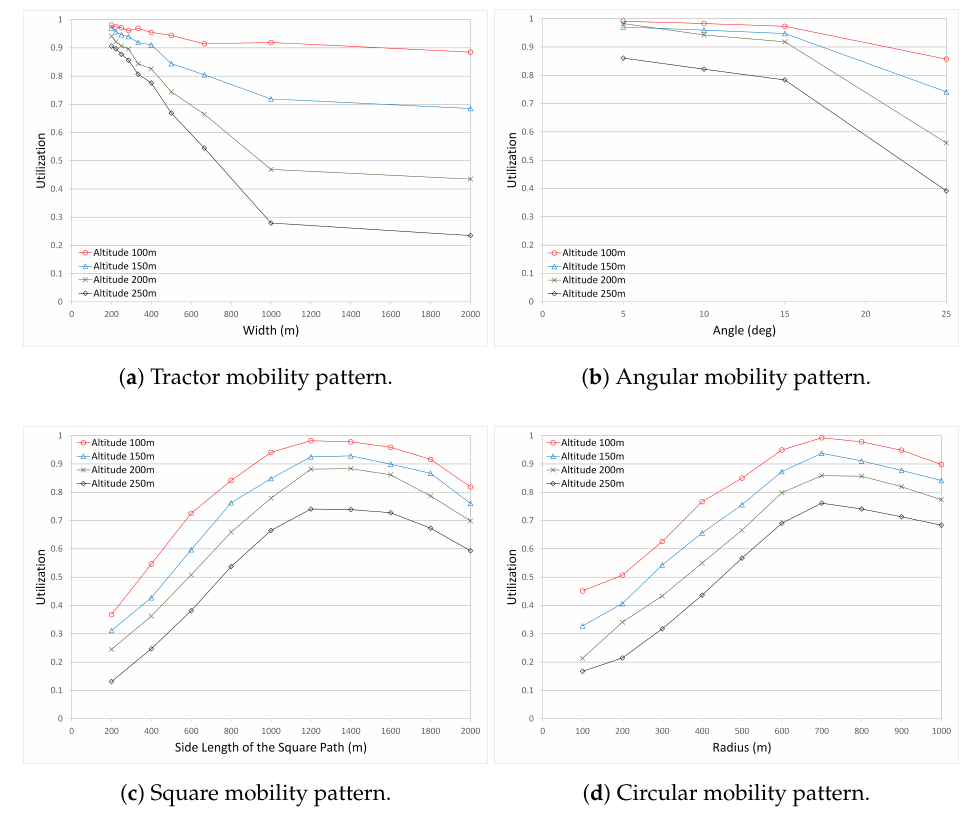
Figure 6. Comparison of the Utilization for all mobility